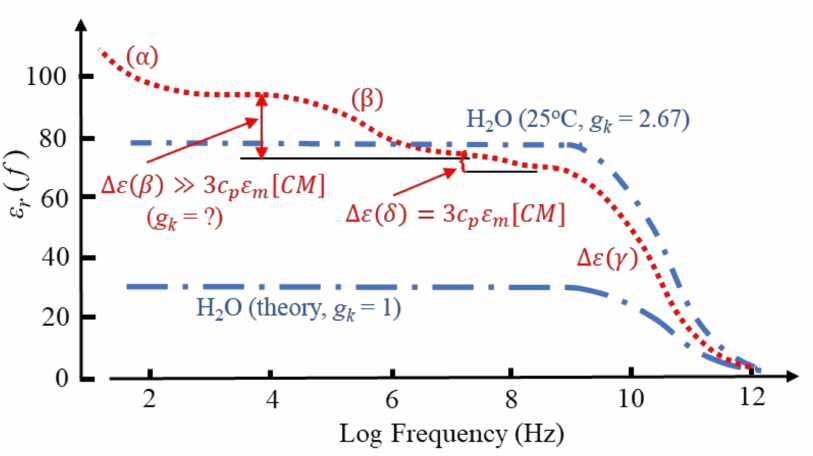
Figure 4. Protein solutions exhibit dielectric dispersions ∆ ε , designated α , β , δ and γ , due to relaxations of the protein’s electrical double-layer; permanent dipole; hydration shell; bulk water dipoles, respectively [16]. The magnitude of ∆ ε ( β ), unlike ∆ ε ( δ ), greatly exceeds that predicted by Equation (16) [4]. ∆ ε ( γ ) exhibited by pure water arises from correlations of its dipole moments (Kirkwood factor g k = 2.67), where g k = 1 corresponds to no